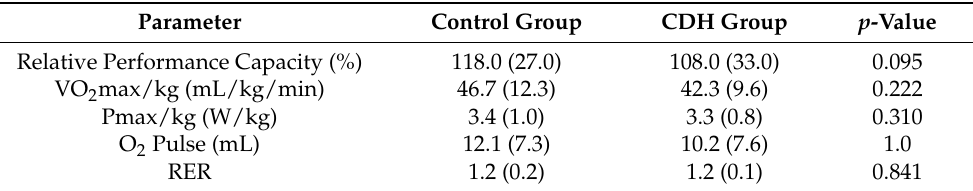
Table 3. Results of exercise performance testing (exhausting bicycle spiroergometry). Data displayed as medians (IQRs).